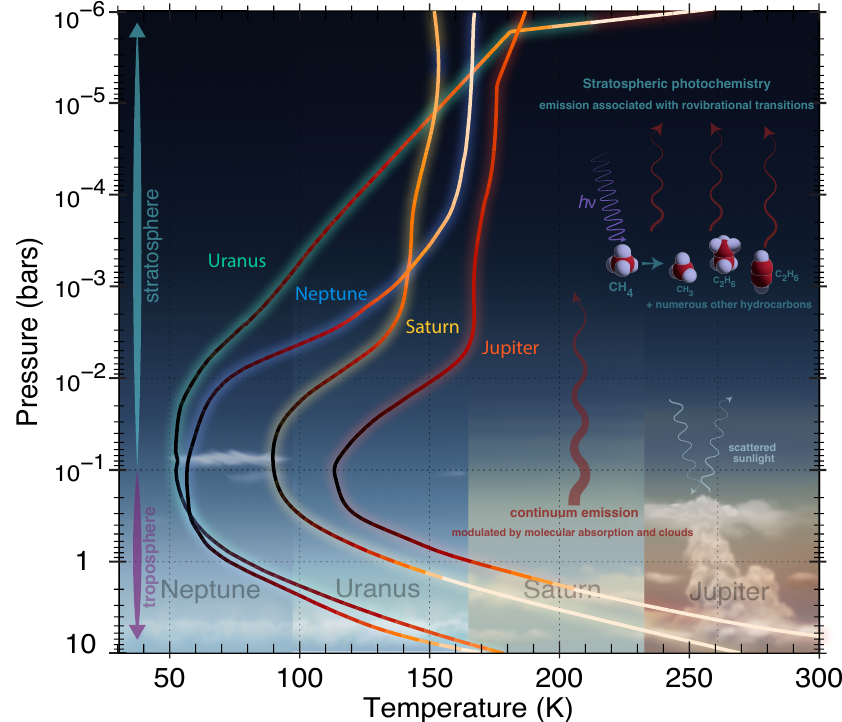
Figure 3. Contributions to observed mid-infrared emission from the giant planet atmospheres. Vertical temperature profiles for Jupiter, Saturn, Uranus, and Neptune are shown for pressures ranging from 10 bar to 1 microbar. While scattered sunlight from aerosols weakly contributes at shorter wavelengths, the mid-IR is dominated by intrinsic thermal emission from the atmosphere. The mid-IR emission originates from heights above the cloud layers, within the upper troposphere and lower stratosphere. Stratospheric emission is primarily associated with various stratospheric hydrocarbons that result from methane